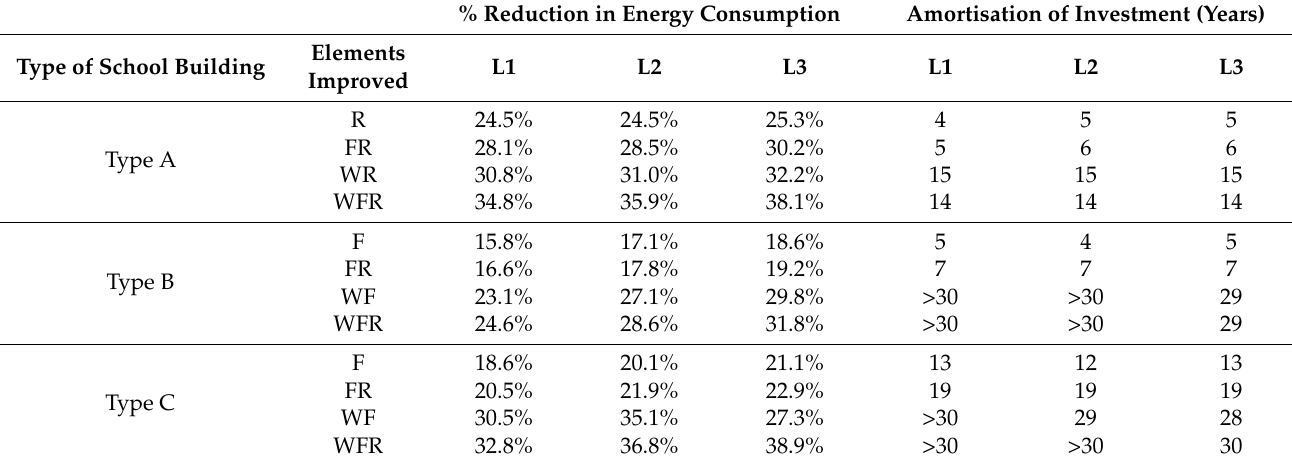
Table 8. Reduction percentage in energy consumption and recovery period of initial amortisation in sets of measures with lower 30-year global cost and a greater consumption reduction, according to type of school